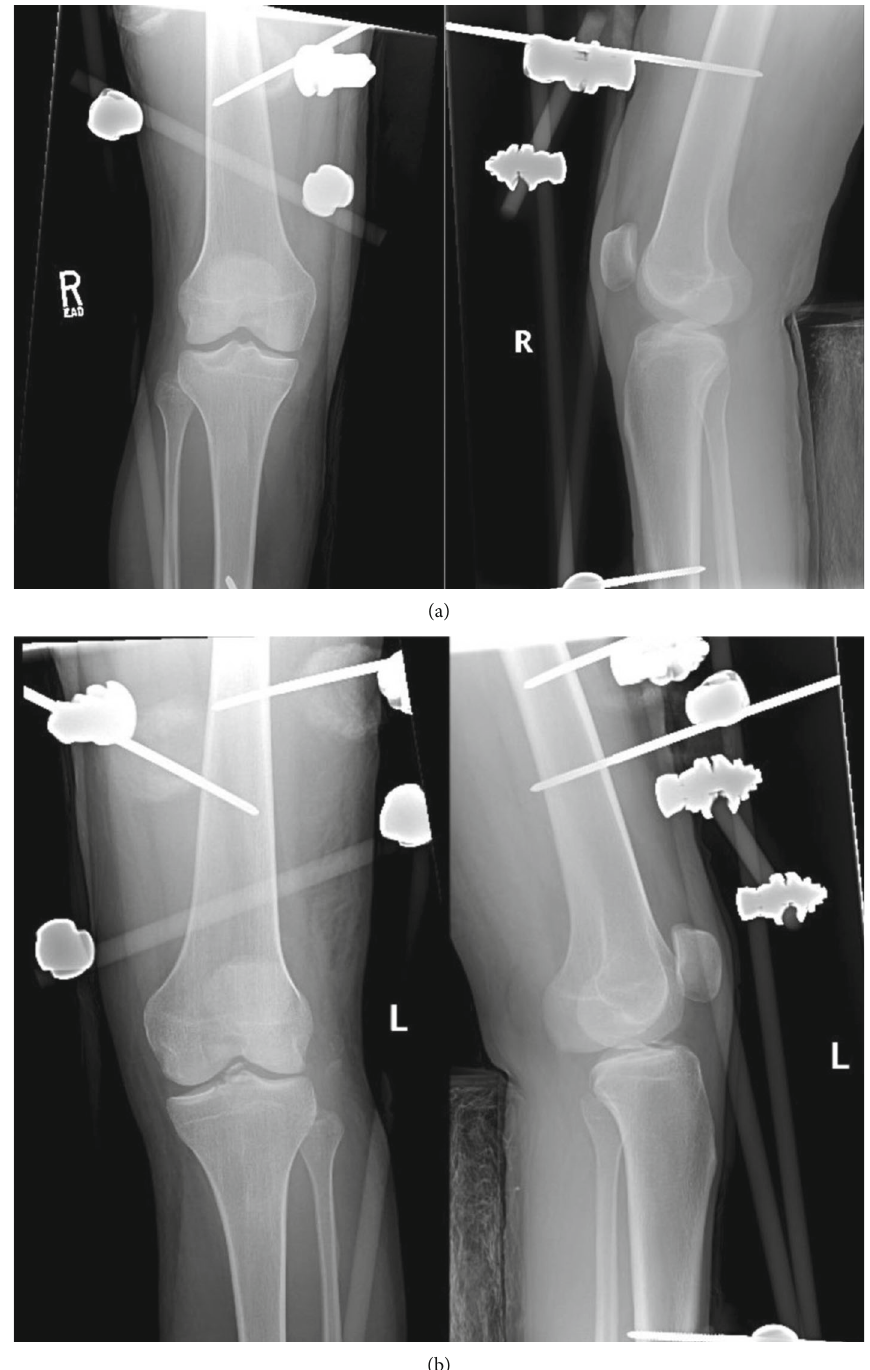
Figure 3: (a) External fi xator application of the right knee. (b) External fi xator application of the left